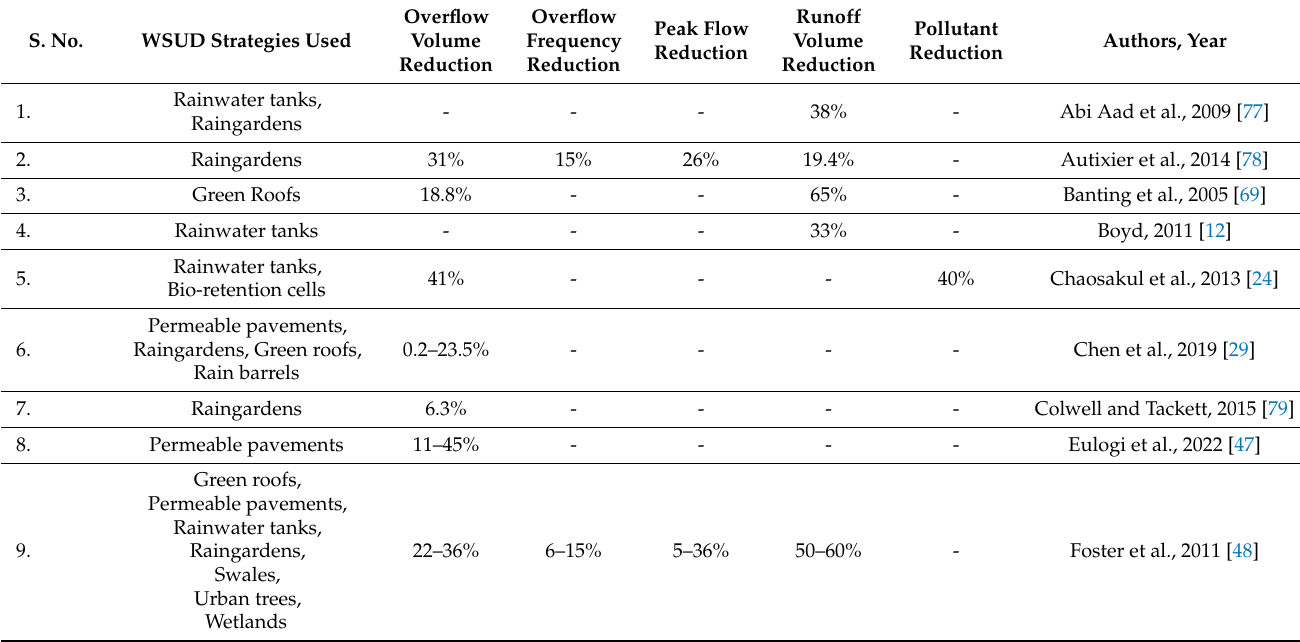
Table 2. Summary of articles highlighting the performance of various WSUD